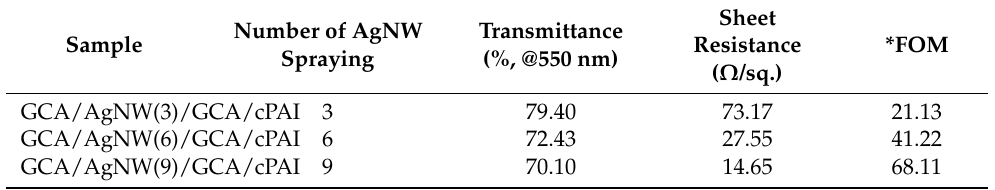
Table 1. The optoelectronic properties of the samples.